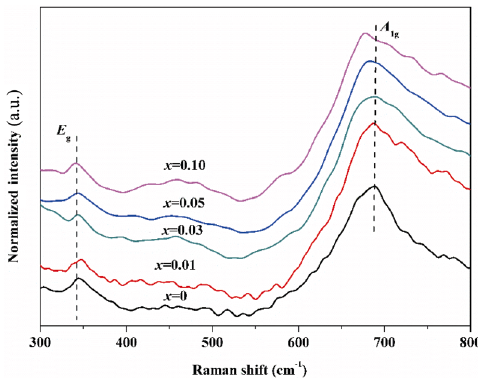
Fig. 7 Raman micrographs of the CuFe 1– x Mn x O 2